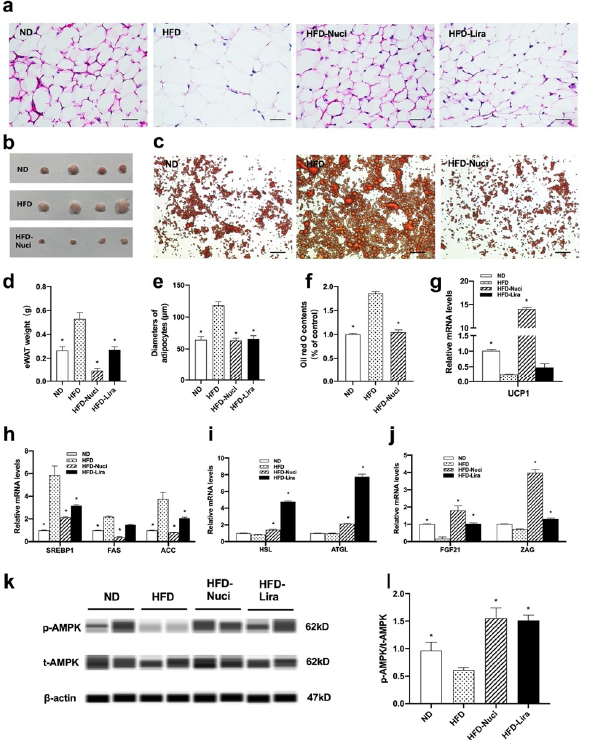
Figure 7. Nuci decreased the weight of eWAT by activating AMPK phosphorylation in HFD-fed mice. Seven-weeks male C57BL/6J mice were fed with ND, HFD, HFD supplemented with Nuci and HFD with subcutaneous injection of Lira at 200 μ g/kg/day for 12 weeks. H&E-staining images of representative sections of mice eWAT in the ND, HFD, HFD-Nuci, and HFD-Lira group, photographs were taken at 400 × magnification ( a ). Diameters of adipocytes were measured from six random fields using Image J software ( e ). The weight of eWAT was measured ( d ). Photographs of isolated mice eWATs in the ND, HFD, HFD-Nuci group ( b ). Representative images of the Oil red O stained mice primary mature adipocytes, photographs were taken at 100 × magnification ( c ) and Oil red O dye was extracted and detected ( f ). The mRNA expressions of UCP1 ( g ) lipogenesis-related genes SREBP1, FAS, and ACC ( h ), lipolysis-related genes HSL and ATGL ( i ), adipokines FGF21 and ZAG ( j ) were determined by RT-qPCR. The protein levels of p-AMPK, t-AMPK, and β -actin were analyzed by Simple western ( k ), the expression of p-AMPK was normalized against t-AMPK ( l ). Data were presented as mean ± SE, n = 12 in each group. * p < 0.05 vs. the HFD